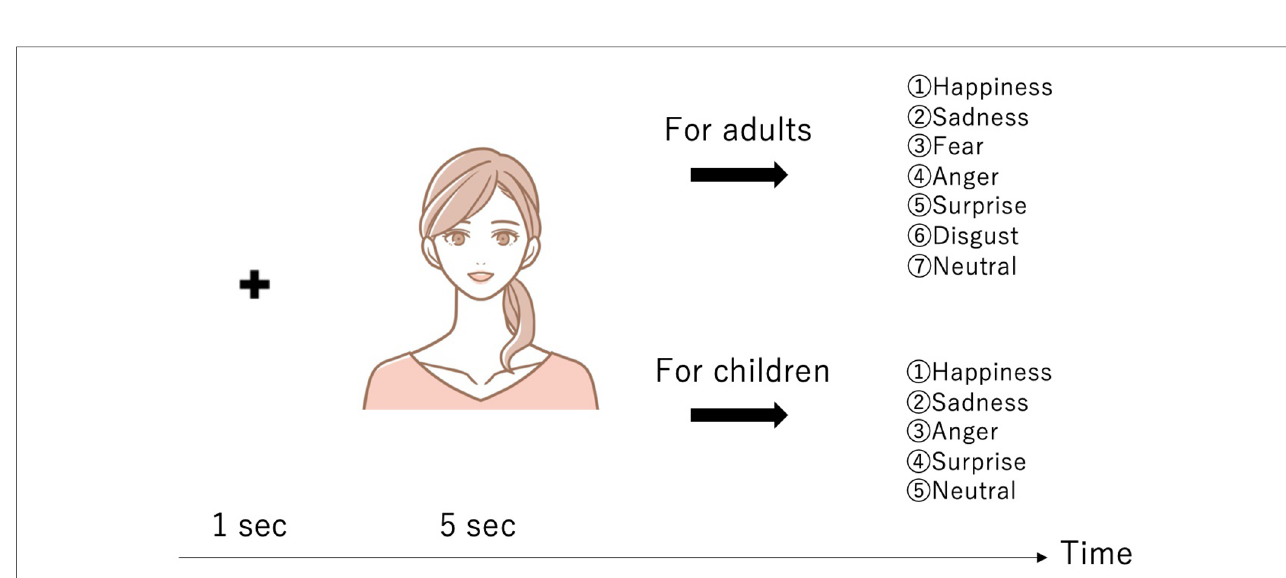
FIGURE 2 Experimental procedure: The adults were asked to choose from seven emotions (Happiness, Sadness, Fear, Anger, Surprise, Disgust, and Neutral), while the children were asked to choose from fi ve emotions (Happiness, Sadness, Anger, Surprise, and Neutral). The actual images could not be depicted due to the FEIT ’ s copyright. Therefore, the images shown are